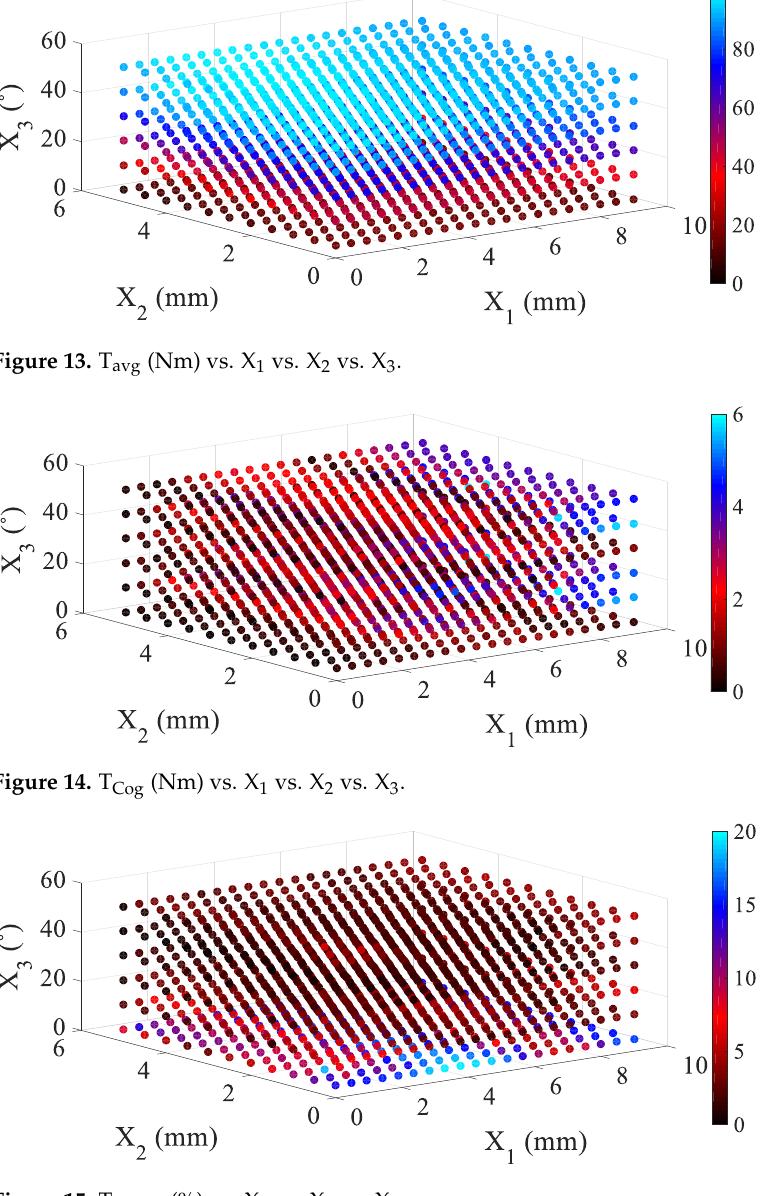
Figure 15. T Ripple (%) vs. X 1 vs. X 2 vs. X 3. Table 3. Output Data of the Optimized Models.